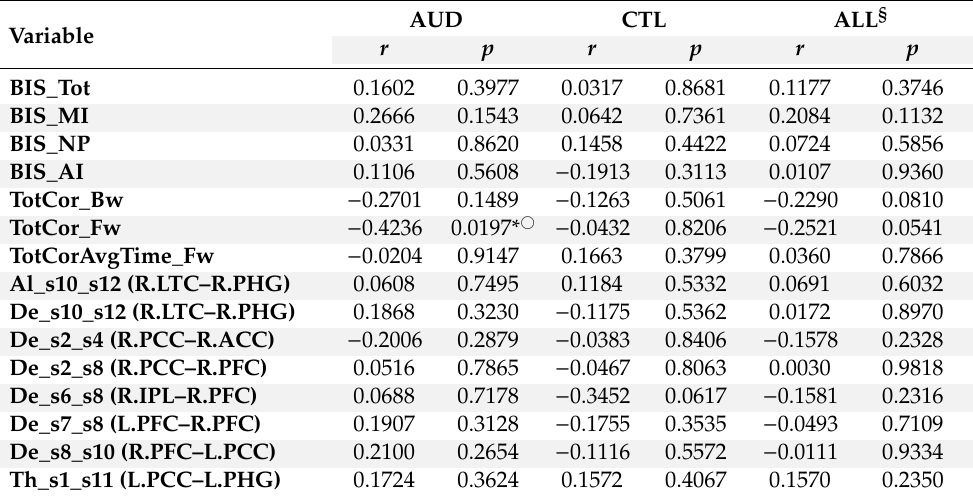
Table 4. Pearson bivariate correlations between age of the participant and the significant variables. Correlation co-efficient ( r ) and p -values (before Bonferroni correction) are provided for alcohol use disorder (AUD), control (CTL) group, and the total sample (ALL). None of the variables achieved the Bonferroni threshold of significance ( r ≥ 0.49 and p < 0.001).